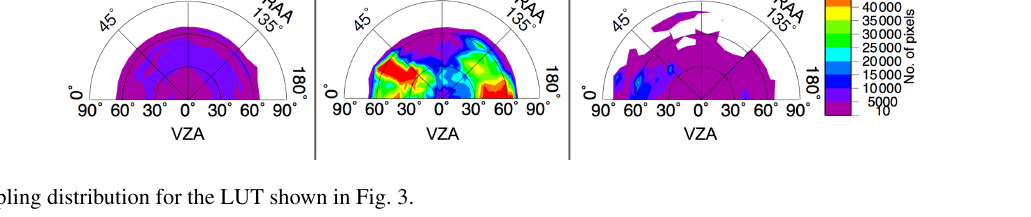
Figure 4. Sampling distribution for the LUT shown in Fig.